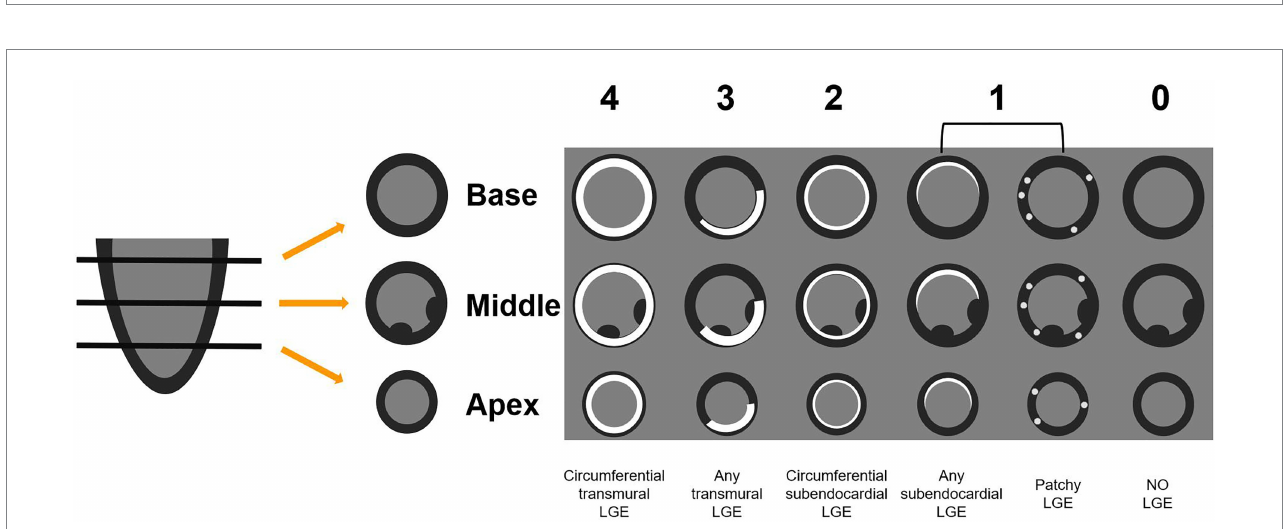
FIGURE 2 The QALE score system detailed grading rule. Circumferential transmural LGE is scored as 4; if there is any transmural LGE, then the score is 3. Circumferential subendocardial LGE is scored as 2; any subendocardial or patchy LGE is scored as 1. No LGE is scored as 0. The global left ventricular LGE score was calculated by adding the scores of the basal, mid-ventricular and apical segments. QALE, query amyloid late enhancement; LGE, late gadolinium